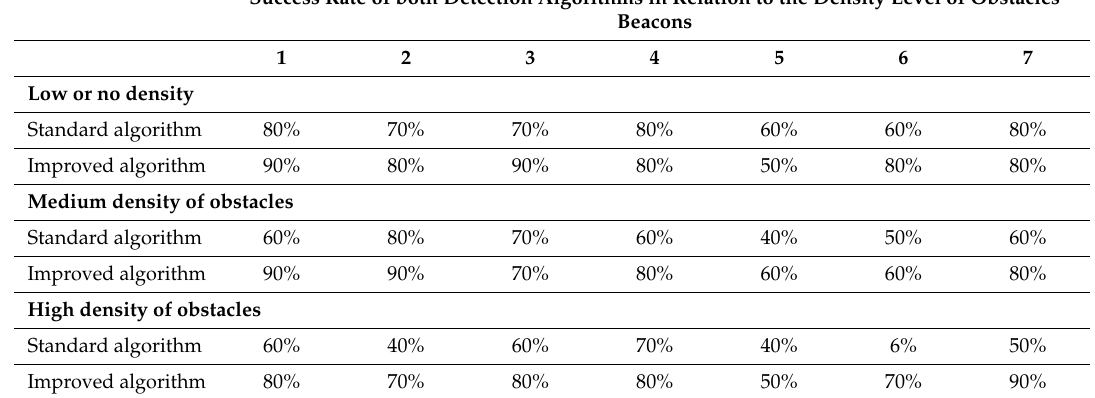
Table 6. The success rate of correct transmitter detections for different environment settings (controlled room). Success Rate of both Detection Algorithms in Relation to the Density Level of Obstacles Beacons